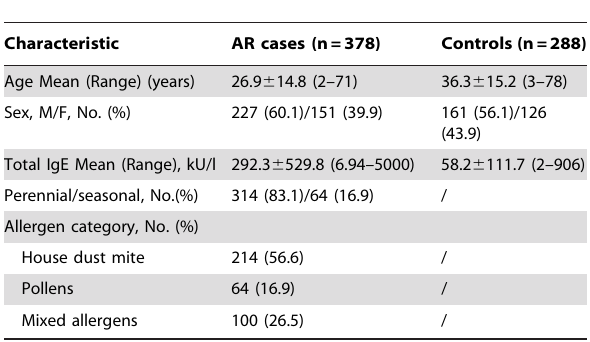
Table 1. Demographic characteristics of the study